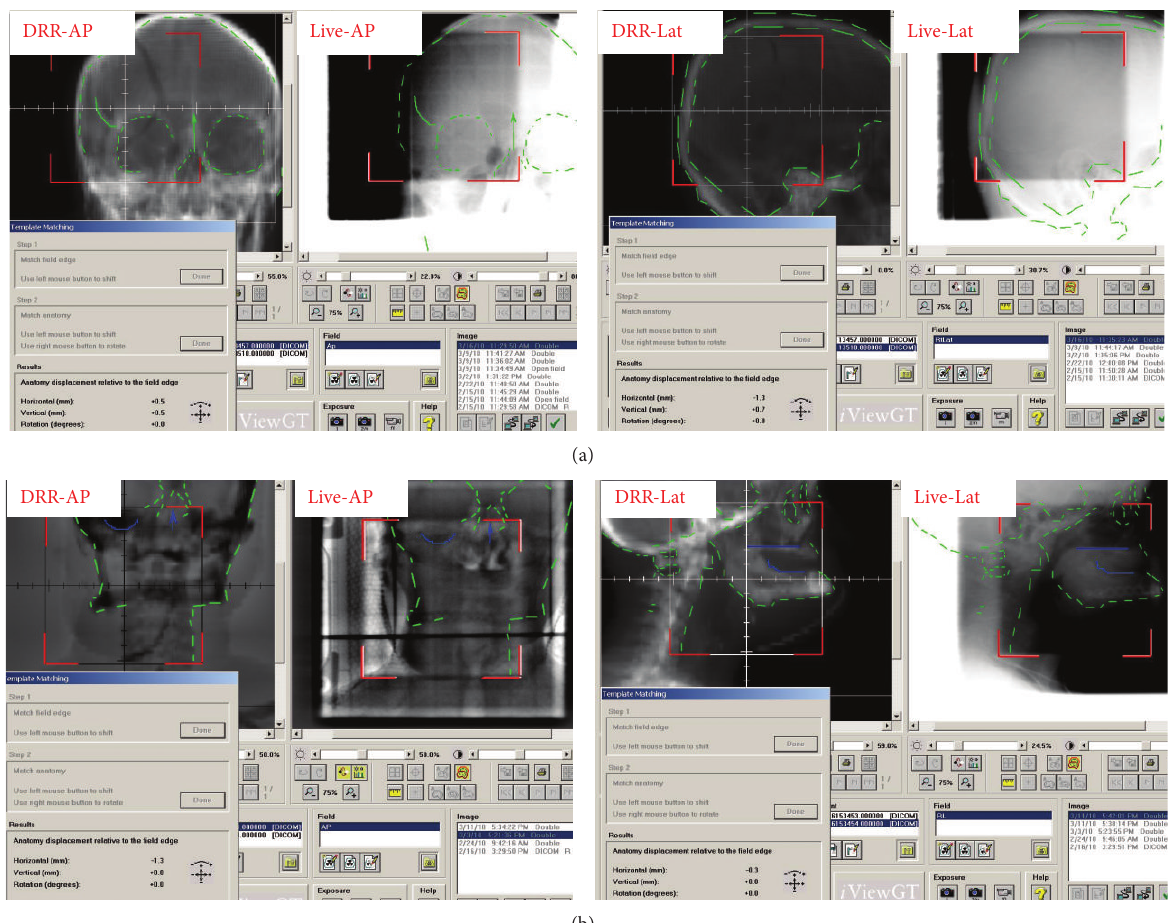
Figure 1: Use of MV EPID for online correction using orthogonal 2D images (anteroposterior and lateral). Both the field and the bony anatomy are matched sequentially to give an estimate of error. The comparison of live image with reference DRR helps assess and correct translational shifts but does not estimate rotational errors. (a) Right parietal glioma. (b) Head and neck cancer. MV: Megavoltage; EPID: Electronic portal imaging device; 2D: two-dimensional; DRR: Digital reconstructed